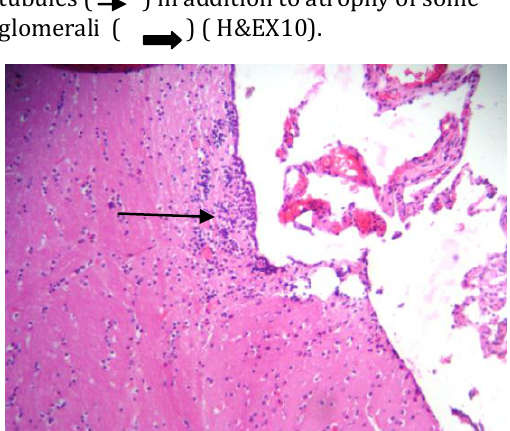
Fig (19): heart at day 9 pi. revel inflammatory cells infiltration between muscles fiber ( ). ( H&EX10).